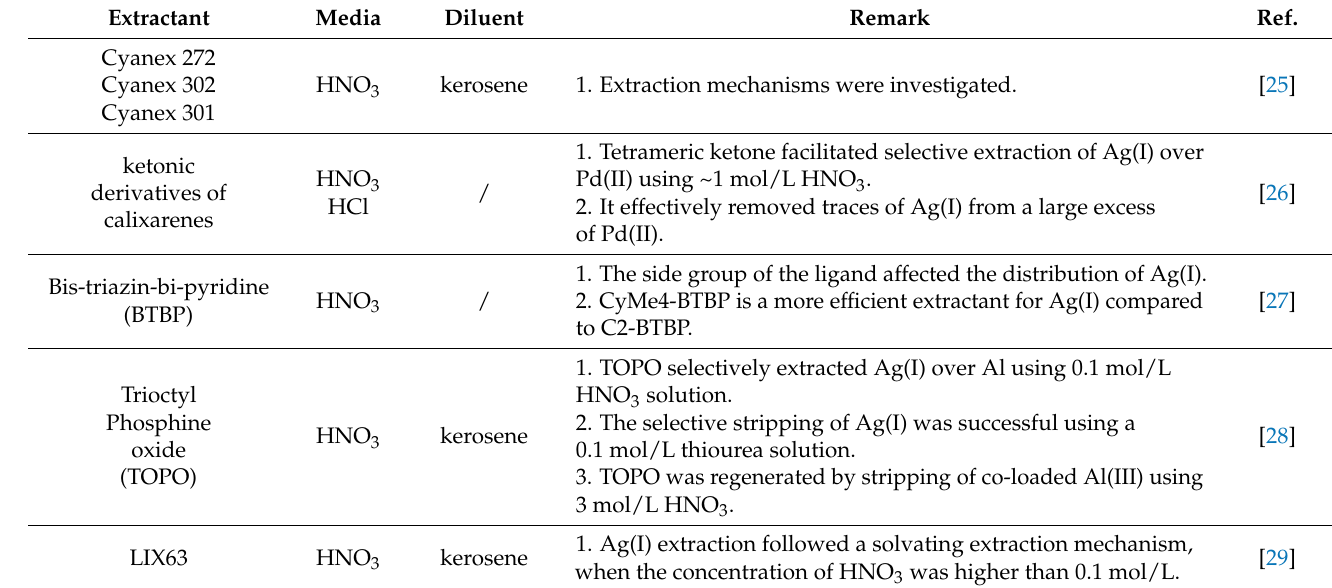
Table 2. Summary of some studies on the extraction of Ag(I) using various